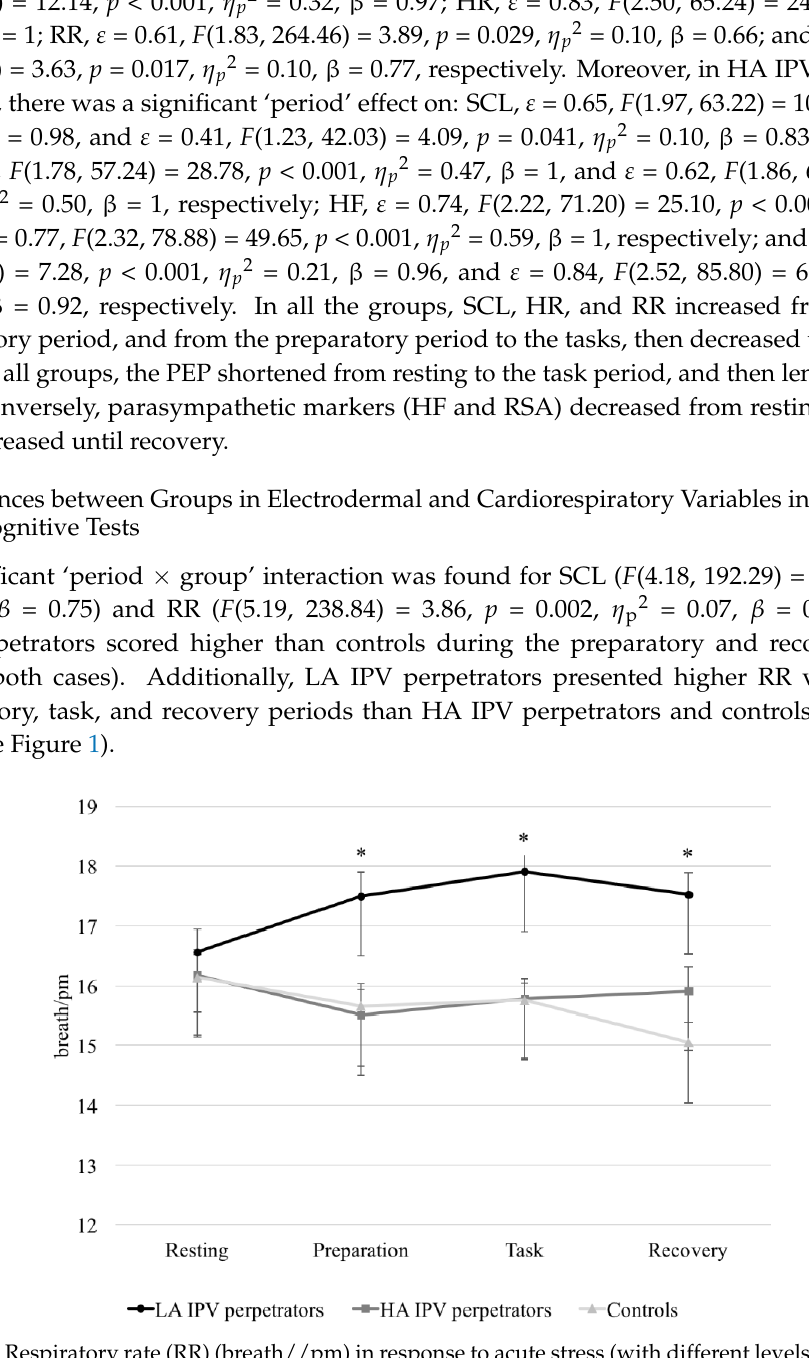
Figure 2. Skin conductance level (SCL) average in response to acute stress for IPV perpetrators (with different levels of alcohol consumption) and controls (* p < 0.05).